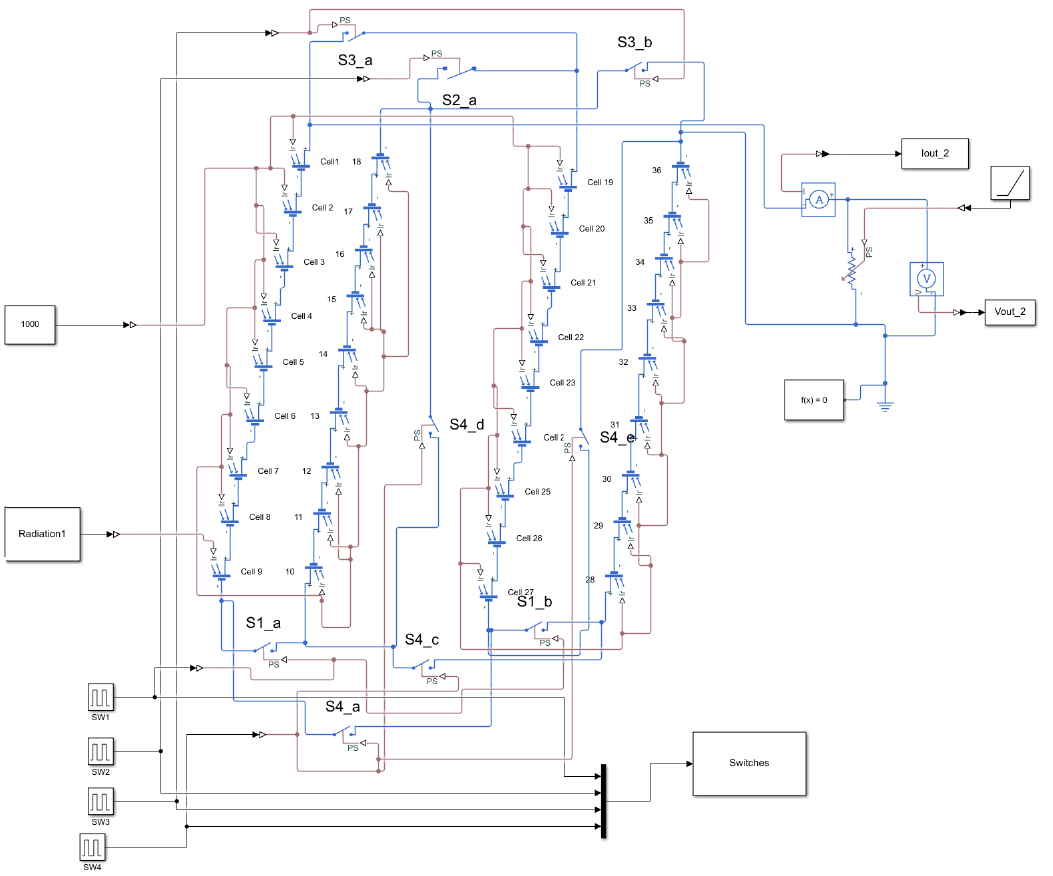
Figure 7. Proposed model for the 36-cell PV module designed in MATLAB/Simulink.